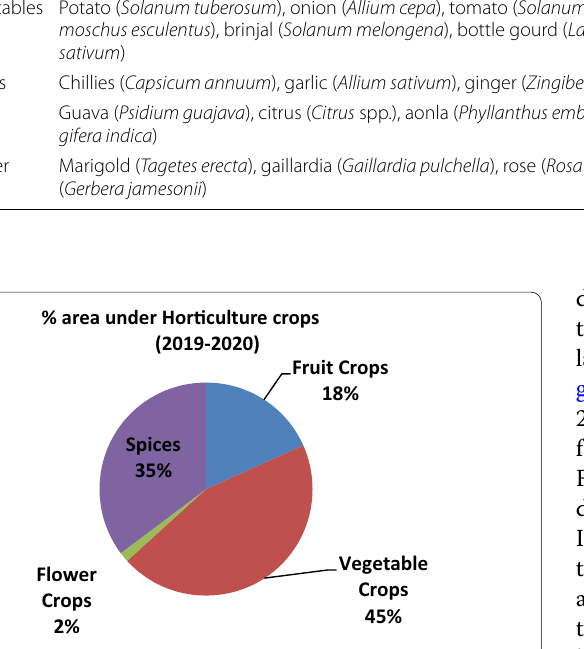
Fig. 2 Per cent area under different horticultural crops cultivated in Madhya Pradesh. The maximum cultivated area is of vegetable crops followed by spices, fruit and flower